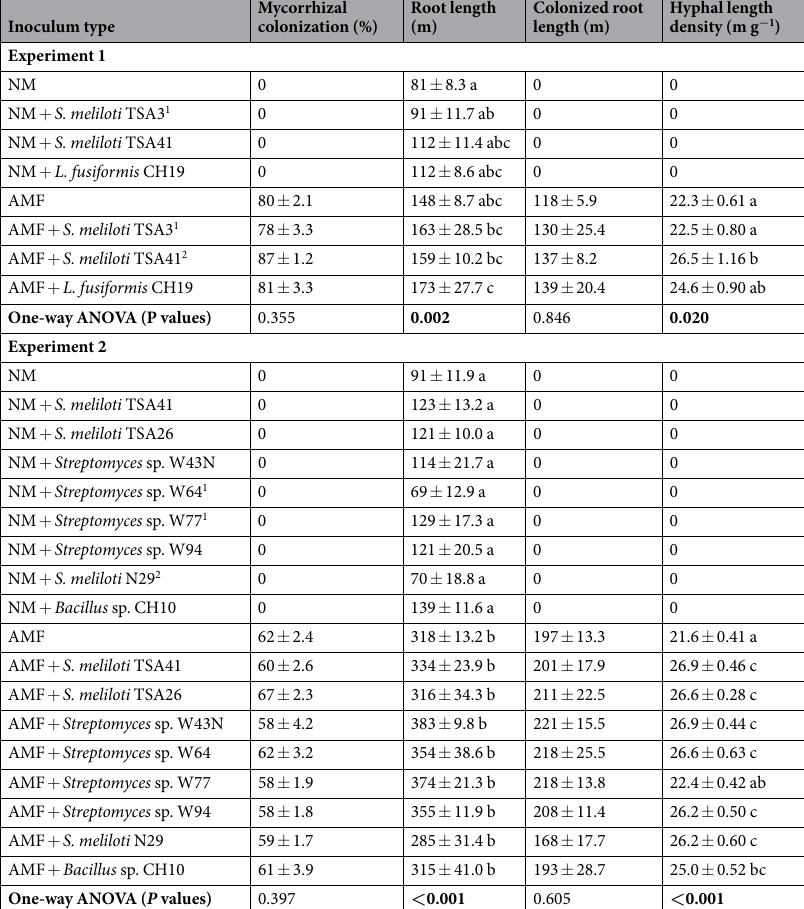
Table 1. Mycorrhizal colonization, root length, colonized root length and hyphal length density in HC soil in Zea mays L. Oh43 inoculated, or not (NM), with Rhizophagus irregularis (AMF) alone or in combination with different bacterial strains. Data are presented as the mean ± s.e.m. (n = 5). Different letters indicate significantly different values based on one-way ANOVA ( P < 0.05). * Values in bold type indicate factors that had significant effects. 1 Treatment with four biological replicates; 2 Treatment with three biological